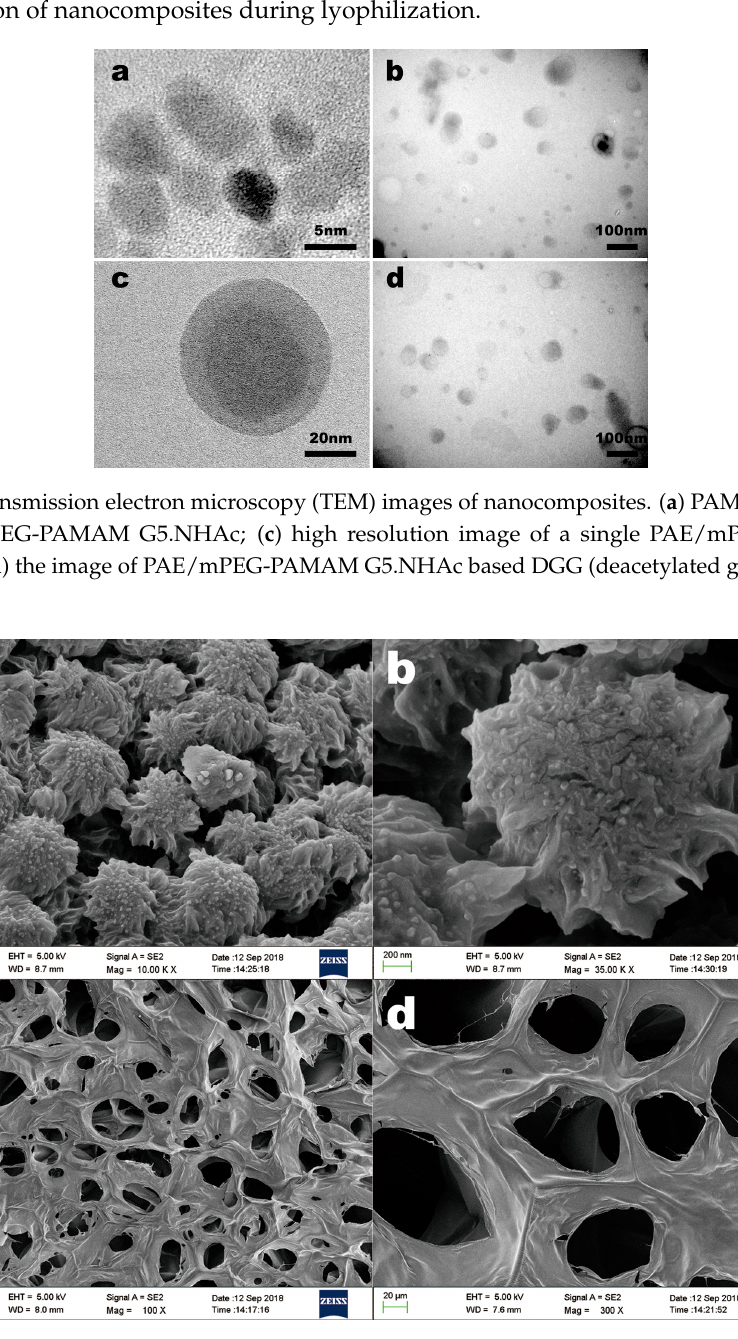
Figure 4. Scanning electron microscopy (SEM) images of the lyophilized PAE/mPEG-PAMAM G5.NHAc ( a , b ) and in situ gel ( c , d ). 3.1.3. EE% and DL%